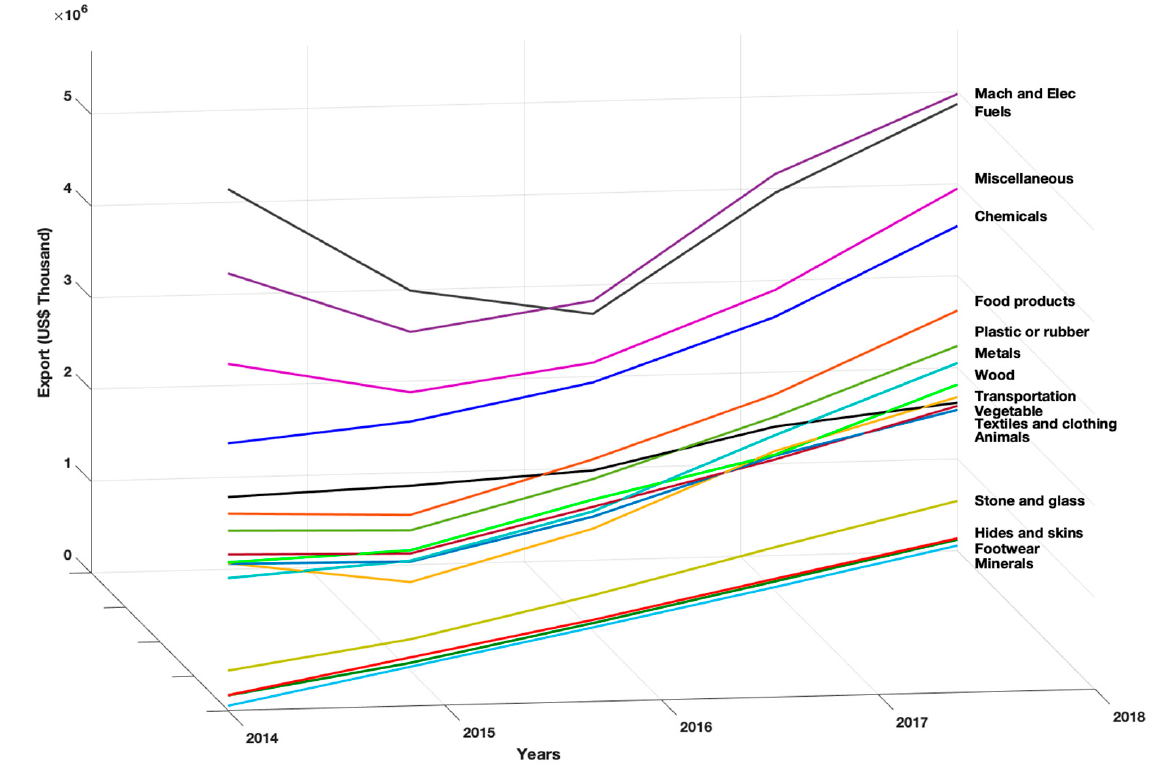
Figure 2. Development of all product groups.